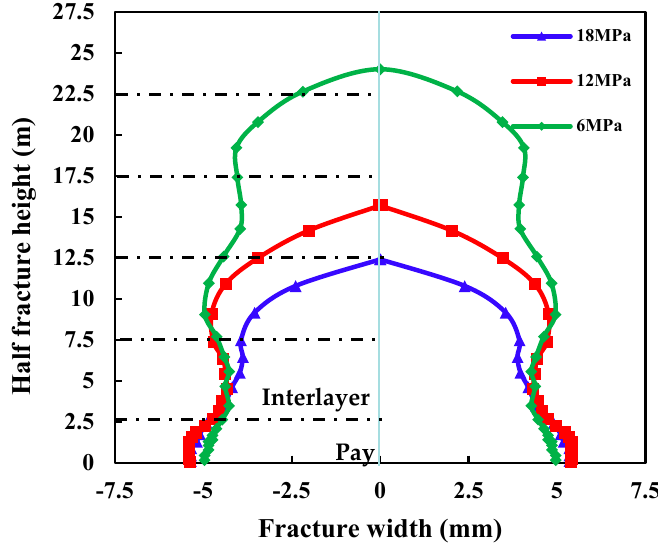
Figure 5. HF morphology under different tensile strengths of the interlayer. As far as HF width is concerned, the difference in tensile strength between the pay zone and interlayer results in wavy distribution of HF width in the vertical direction. The higher the tensile strength of the interlayer, the more difficult it is to penetrate the interlayer, the smaller the HF width in the interlayer, and the smaller the width gap at the HF center. The reason is that the main reservoir factors affecting HF width are in situ stress and Young’s modulus, and the tensile strength of the interlayer will not affect the width of the HF in the pay zone. The tensile strength determines the HF initiation pressure; after the generation of a new HF element, the HF net pressure remains a constant value, thus the HF width has a neglectable